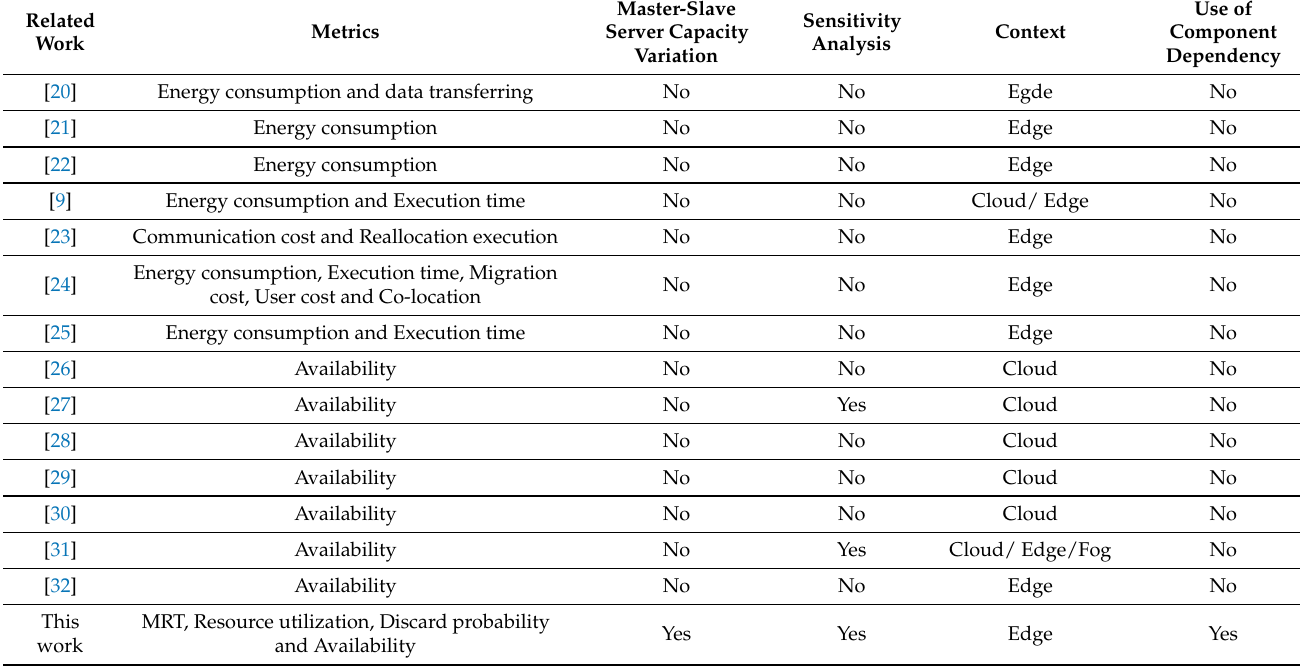
Table 1. Related